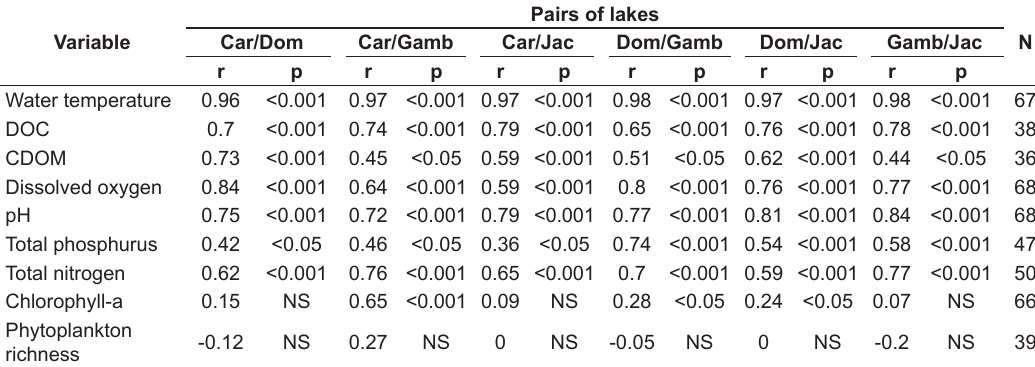
Table 4. Pearson correlation (r) of the different variables for each pair of lakes.